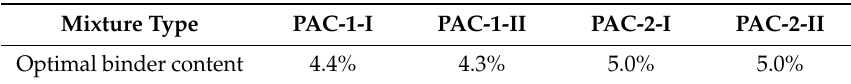
Table 6. Optimal binder content.